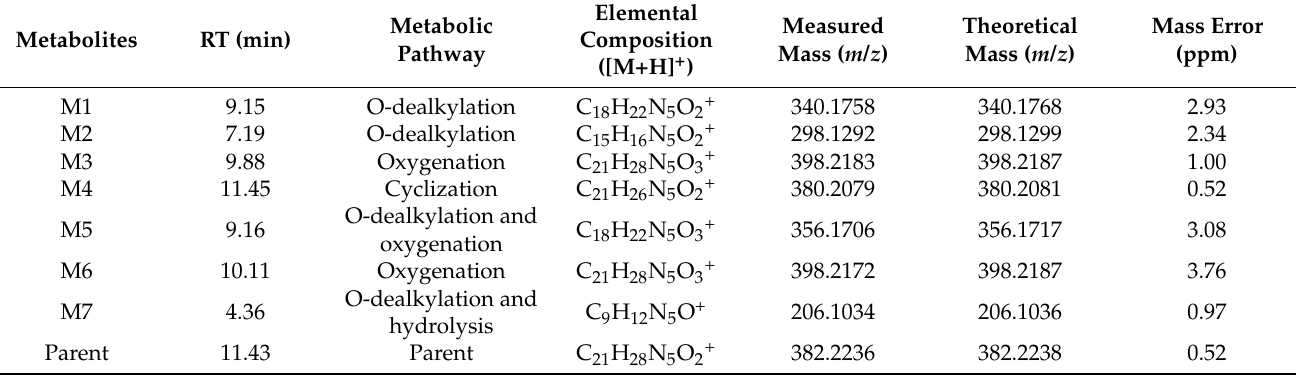
Figure 3. Extracted mass chromatograms of IBG metabolites in rat liver microsomes incubated with IBG for 1.5 h. Table 1. Summary of IBG metabolites in rat liver microsomes.